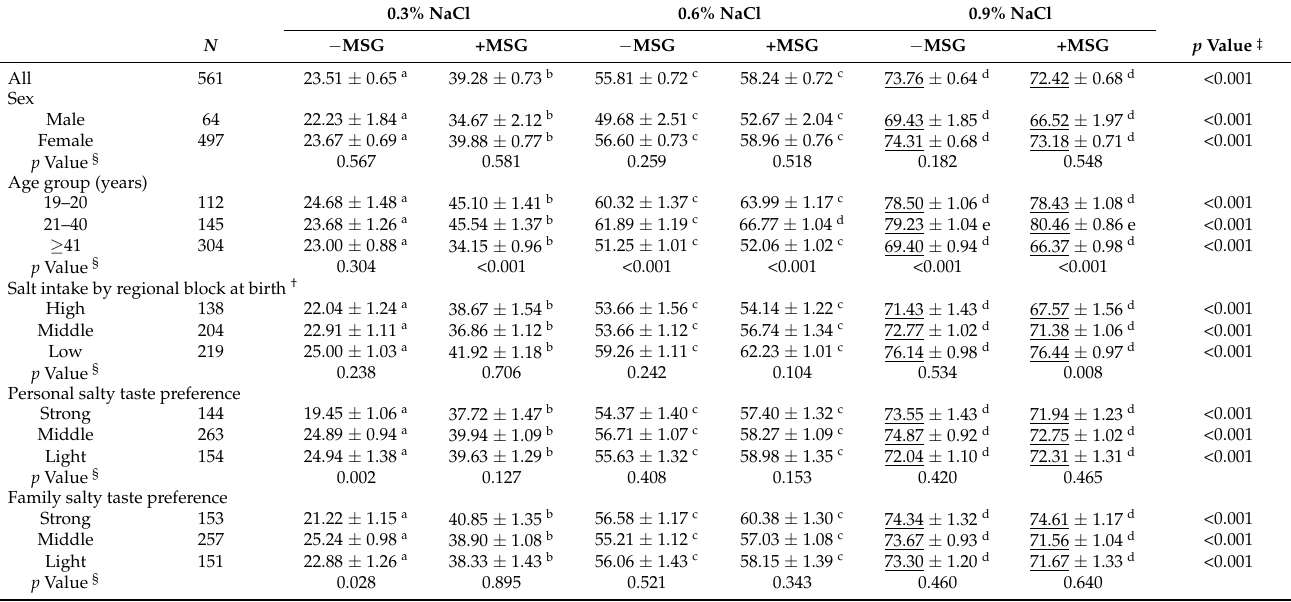
Table 3. Saltiness visual analogue scale (VAS) ratings by sex, age, salt intake by regional block at birth, and salty taste prefer-